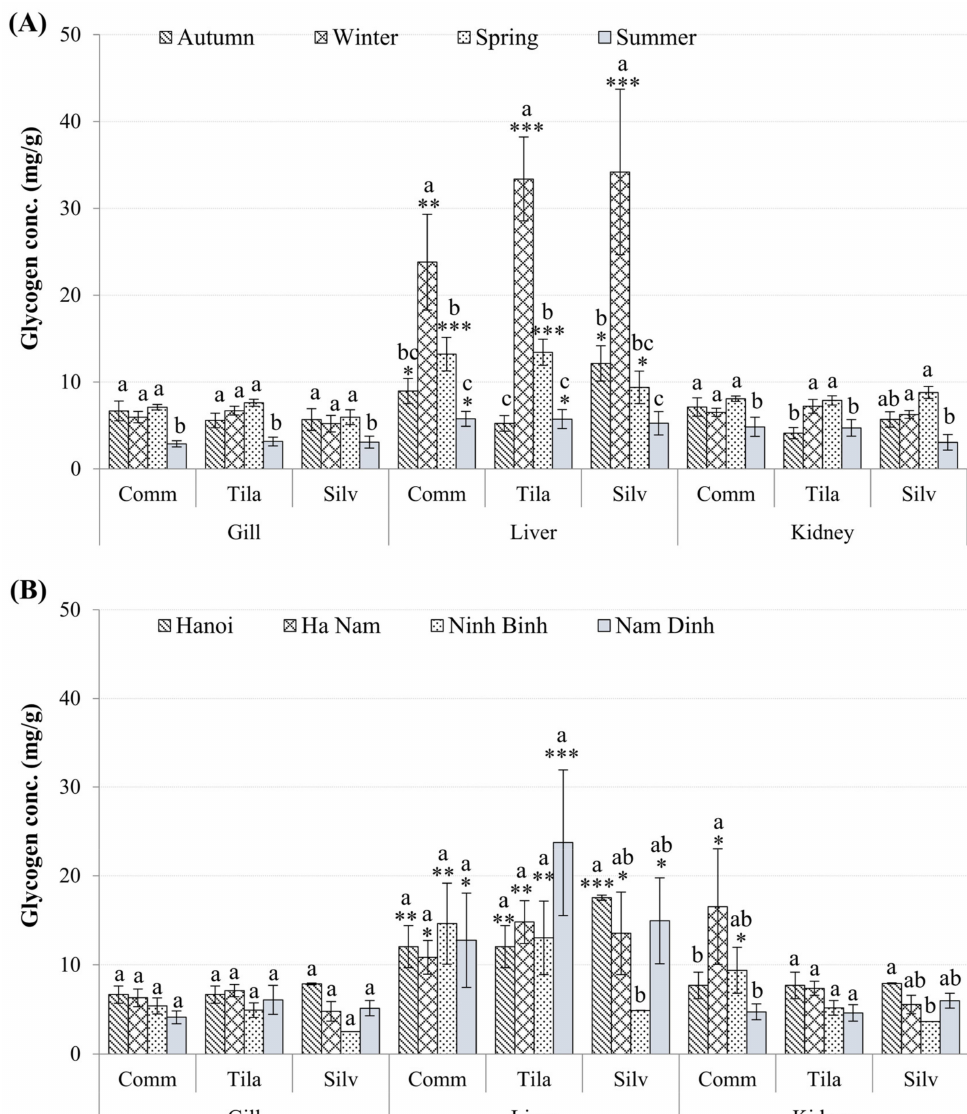
Figure 4. Seasonal and spatial variation in glycogen concentrations (mean ± SEM) in tissues of C. carpio (Comm), H. molitrix (Silv), and O. niloticus (Tila) from selected sampling sites. Significant differences in glycogen levels, of all tissues of three fish species, between sampling times ( A ) and sites ( B ) in comparison to the lowest value (*) are shown (mean ± SEM, n = 10–20, * p < 0.05, ** p < 0.01; *** p < 0.001). Different letters (a > b > c) indicate that the variation of glycogen values between seasons ( A ) or between locations ( B ) within the same organ type is significant ( p < 0.05; ANOVA followed by Tukey–Kramer multiple comparisons